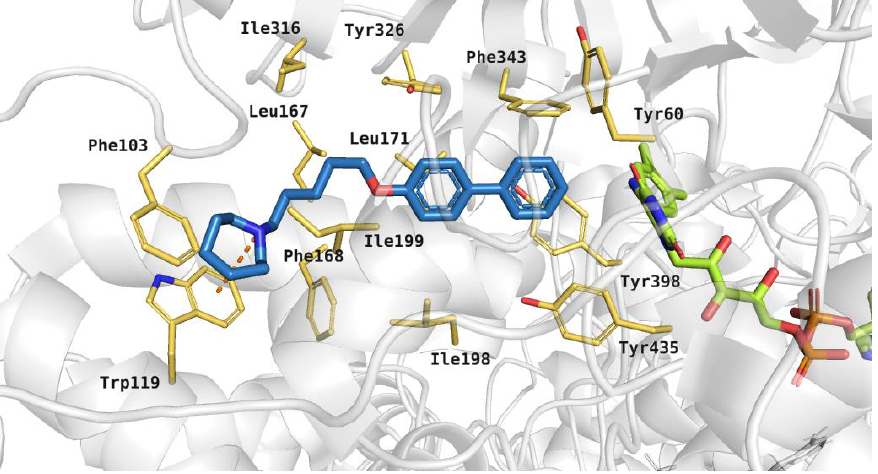
Figure 11. Binding mode of compound 19 within the human MAO B active site. Residues colored in yellow, green — cofactor FAD, orange dashes — cation- π interactions.